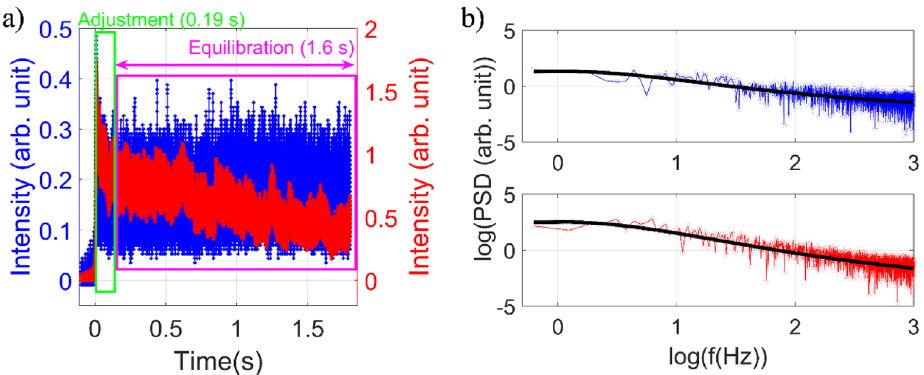
Figure 3. Plots of ( a ) backscatter and TPF signals for single trapped particle, and ( b ) corresponding power spectra at 18.80 mW average power under pulsed excitation. Color: red corresponds to the TPF signal, blue corresponds to the backscatter signal, and black corresponds to Lorentzian fit to the power